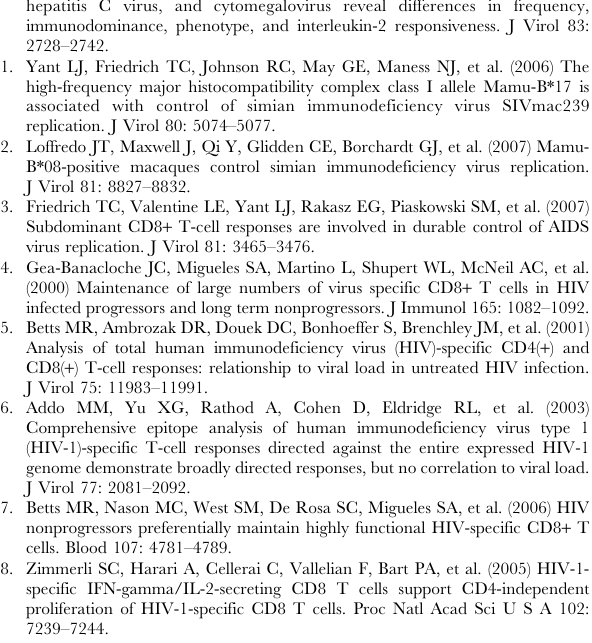
Figure S1 HIV-specific CD8 + T-cell cytotoxic responses were measured by granzyme B target cell activity and infected CD4 + T- cell elimination in chronically infected patients and Ad5/HIV vaccine recipients. (A) Following incubation with day 6 autologous CD8 + T-cells, granzyme (Gr) B activity in uninfected (left column) or HIV-infected CD4 + T-cell lymphoblast targets (right column) is shown in a representative LTNP (top row) and an Ad5/HIV vaccine recipient (bottom row). Plots are gated on live targets based on staining with a LIVE/DEAD Fixable Violet Stain (see Methods). Net GrB target cell activity after subtracting back- ground values (i.e., responses in uninfected targets, left column) is shown in red font. (B) Cells from A after fixation, permeabilization and staining for CD4 and intracellular p24 expression. Quadrants indicate percentages of gated targets. Infected CD4 elimination (ICE) is shown in red font, which was calculated with p24 + targets (sum of upper quadrants) as described in the Methods. Table S1 Ad5/HIV vaccine recipient characteristics. Table S2 Characteristics of HIV-infected